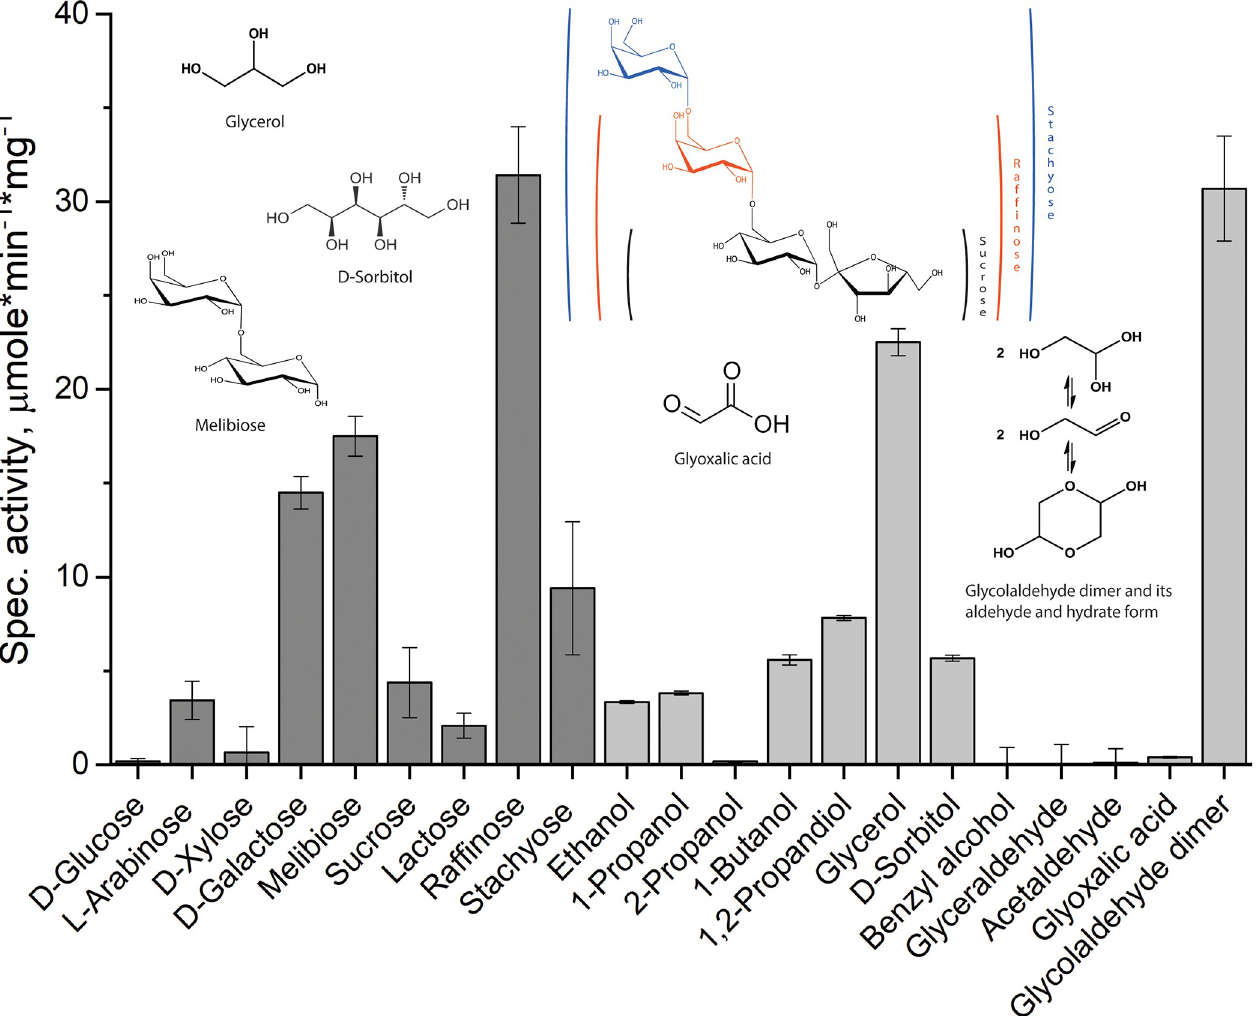
Fig 5. Substrate range of Pru AA5_2A. Pru AA5_2A activity was measured using 300 mM substrate, except for glyceraldehyde, acetaldehyde and glycolaldehyde dimer, where the substrate concentration was 50 mM. Activity on Glyoxalic acid was measured at 15 mM since no activity was detected at 50 mM. In all cases, reactions were performed at 30˚C in 20 mM MOPS (pH 7.5). n = 4; error bars indicate standard